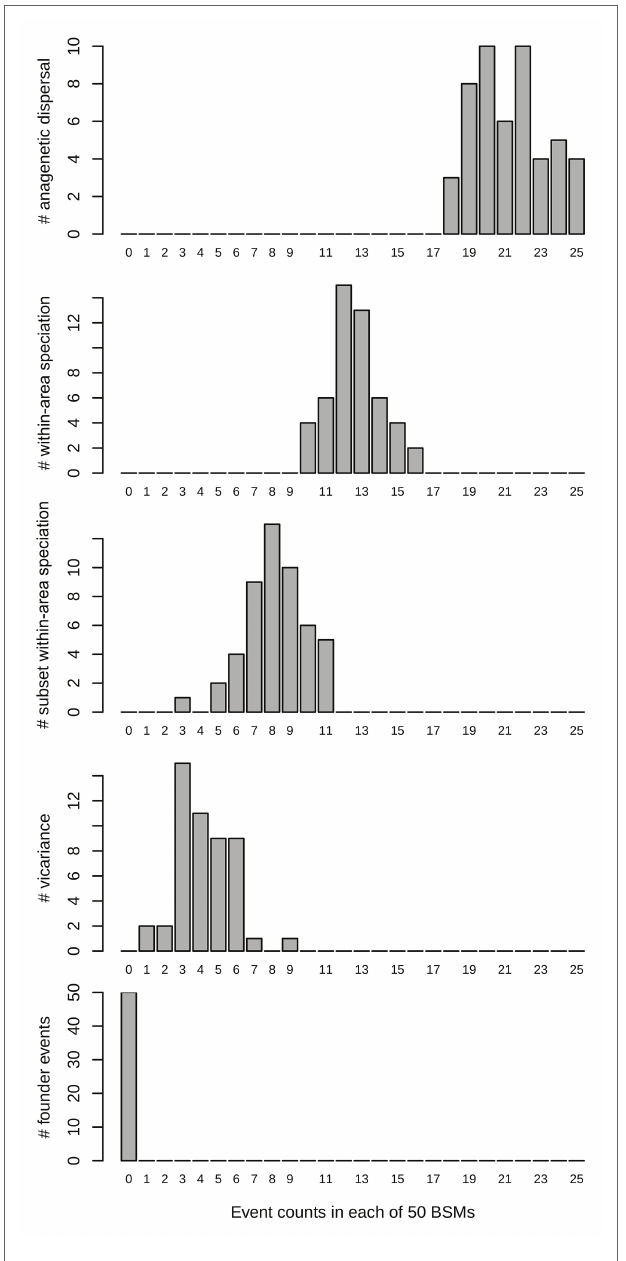
FIGURE 2 | Biogeographical events count after 50 biogeographic stochastic mappings (BSMs) in the best fitting model obtained in BioGeoBEARS (constrained DEC model) in Centaurium . The horizontal ( x ) axis represents the number of events, and the vertical ( y ) axis the number of BSM